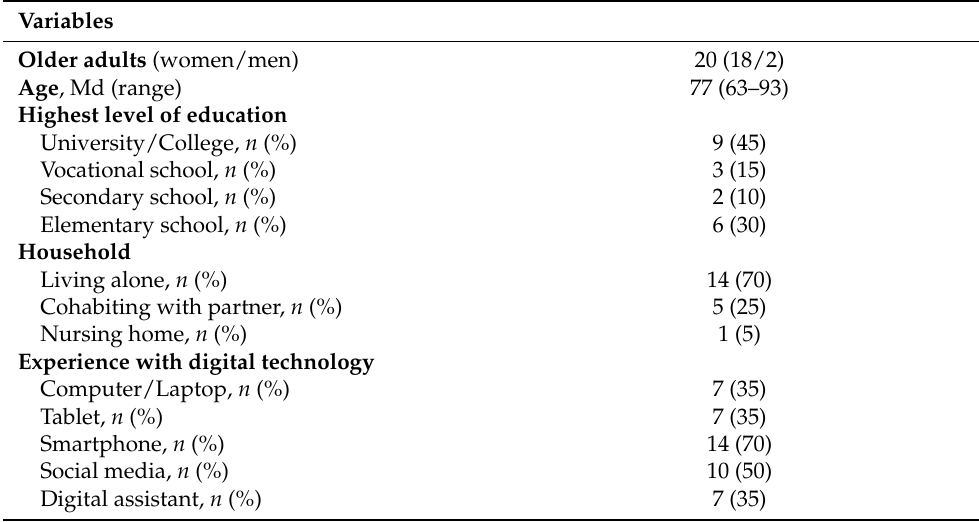
Table 2. Characteristics of the older adults ( n =